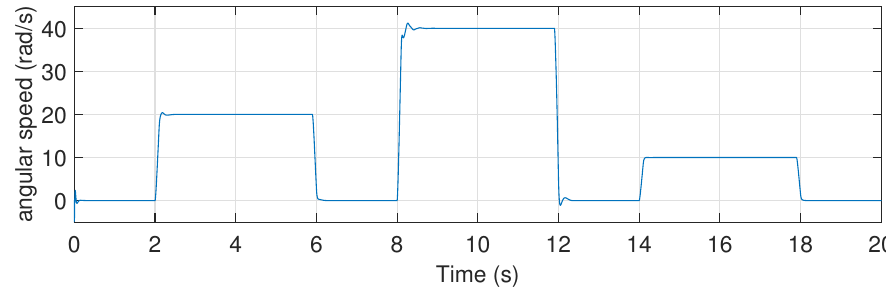
Figure 4. Simulation result: motor angular speed ω under the PI controller and proposed observer.